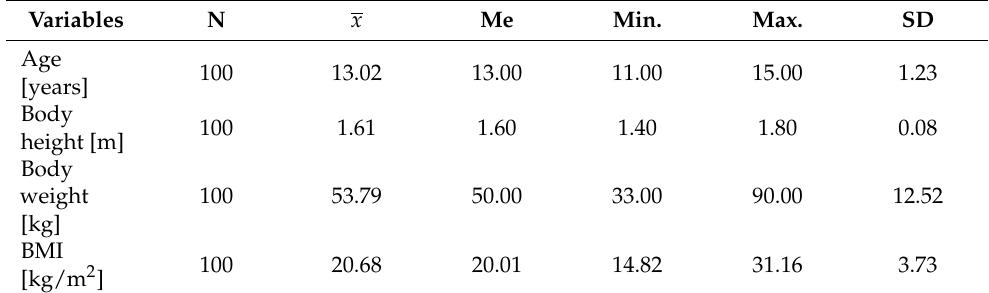
Table 3. Characteristics of the studied